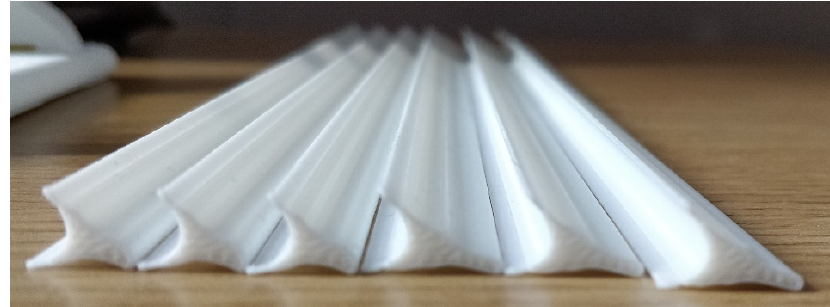
Figure 7. 3D printed ice shapes.